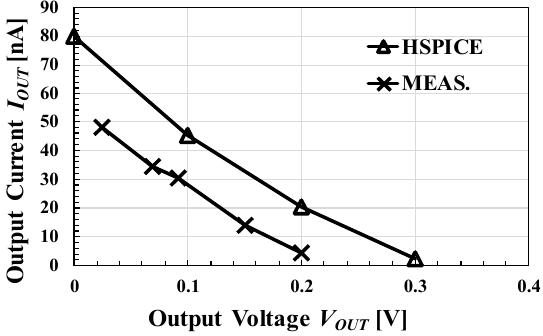
= 1 kHz, V = 0.5 V, R = 500 Ω DD EH